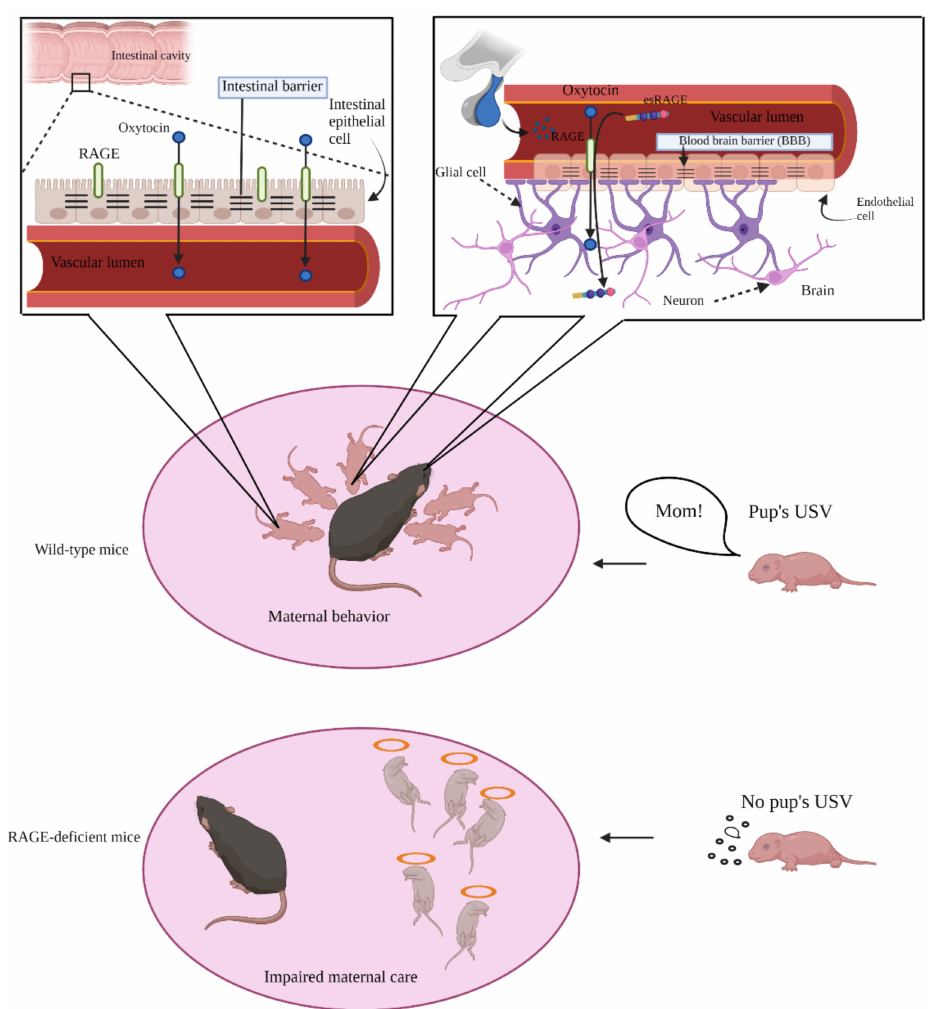
Figure 2. Schematic diagram of mRAGE as an oxytocin (OT) transporter in the intestinal barrier and the blood–brain barrier (BBB) for nurturing mother–infant bonding. The ultrasonic vocalization (USV) is an early communicative behavior between pup and